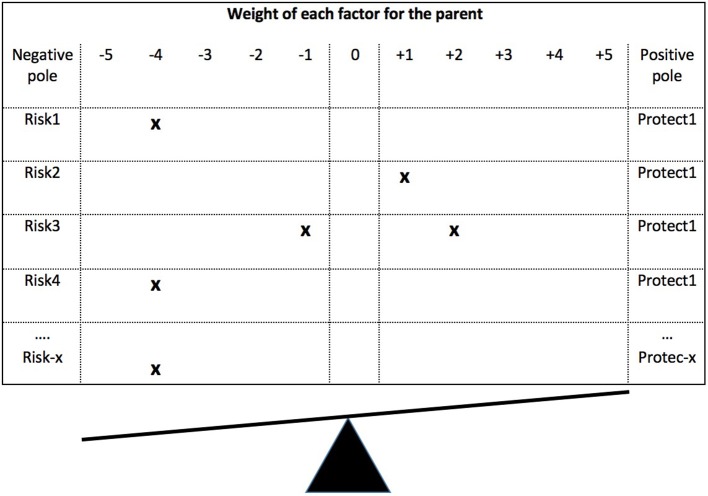
Operationalization method of the balance between risks and resources.